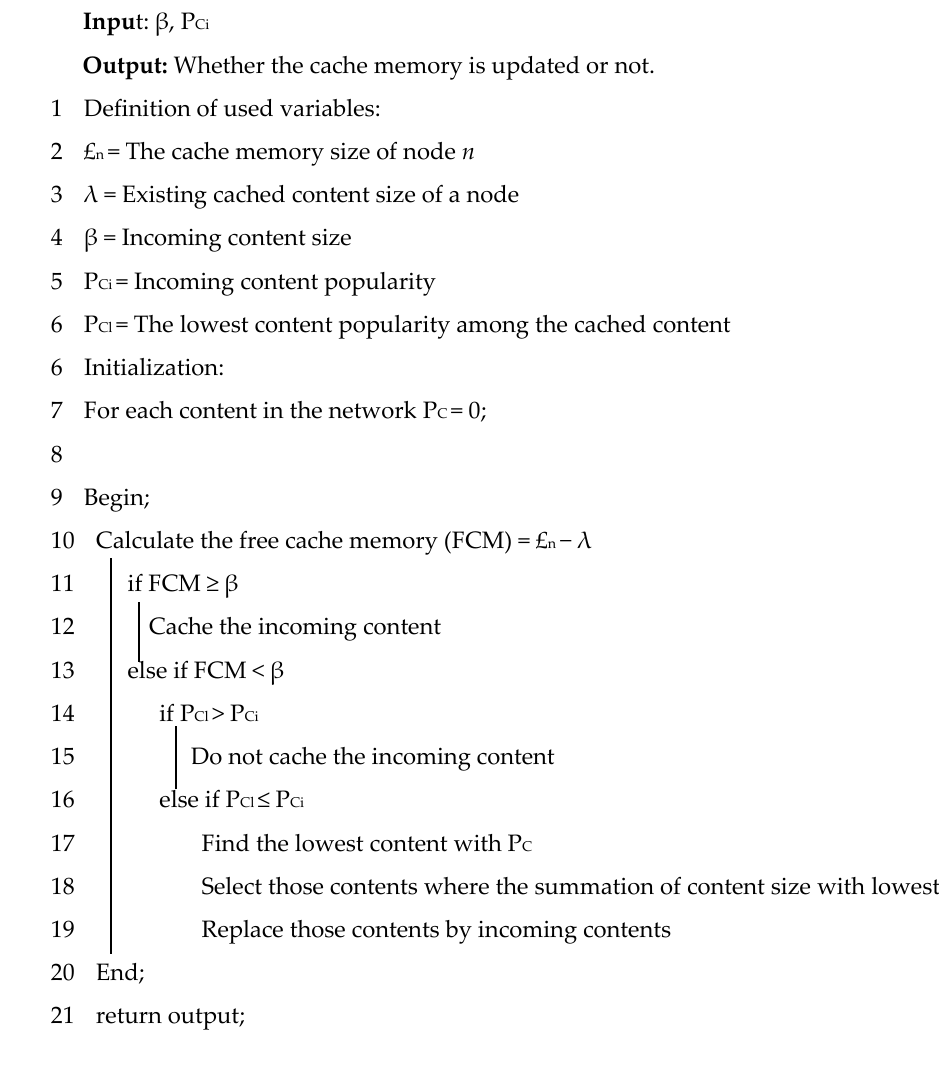
Algorithm 2: An algorithm for content replacement in the cache memory.